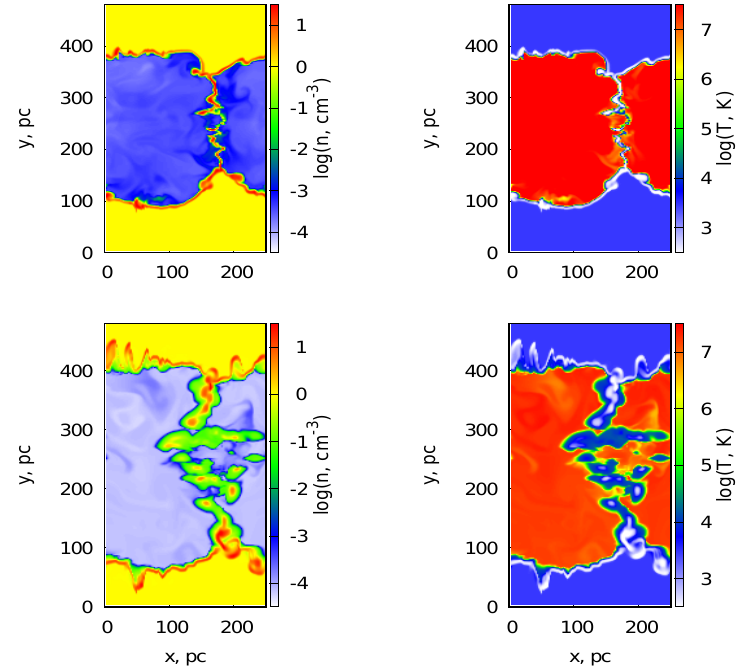
Figure 2. The density (left column) and temperature (right column) slices of the region, where two bubbles collide, at time moments 3.5 Myr (upper panels) and 5.5 Myr (lower panels). The collision occurs, when the age of each bubble is 2.5